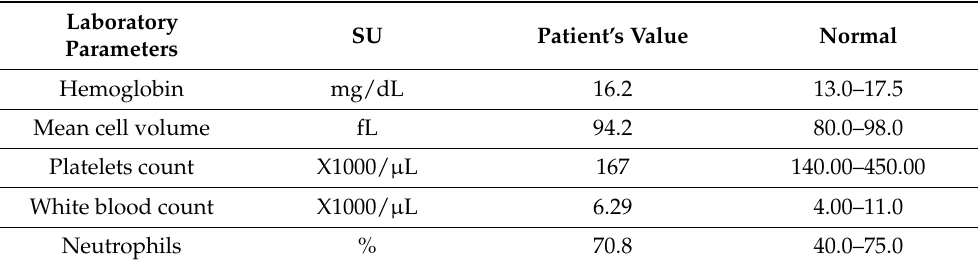
Table 1. Main laboratory analyses result with the reporting systemic unit (SU) of measurements and the normal value